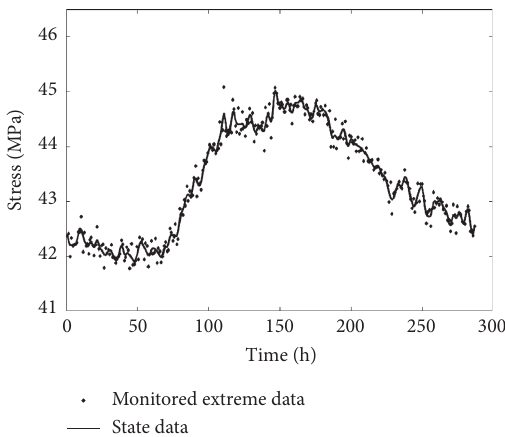
Figure 7: Monitoring extreme stress data and state